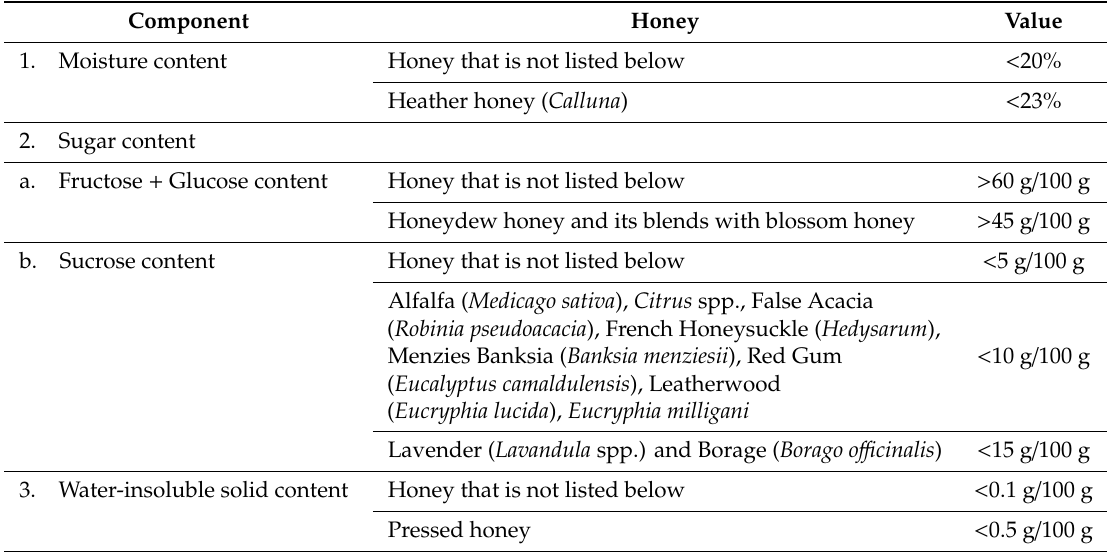
Table 1. Essential composition and quality factors of pure honey (adopted from Wei et al. [43]).